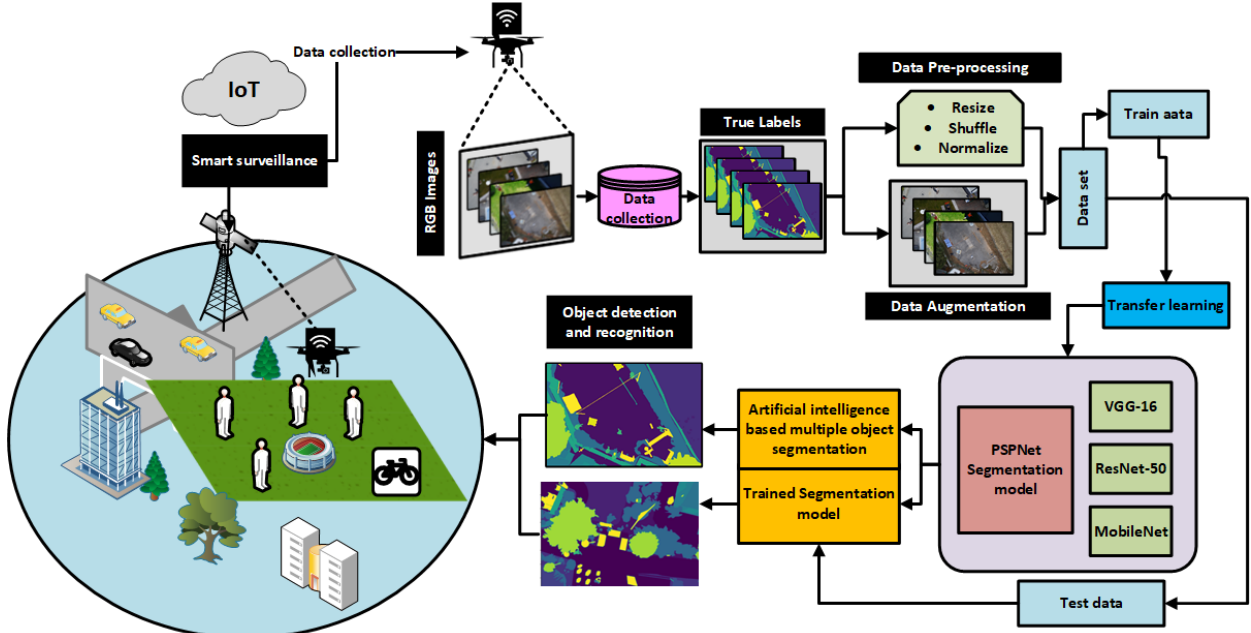
Figure 2. An IoT-enabled multiple object segmentation system based on deep learning using aerial drone data set. The overall system is based on a segmentation model with and CNN